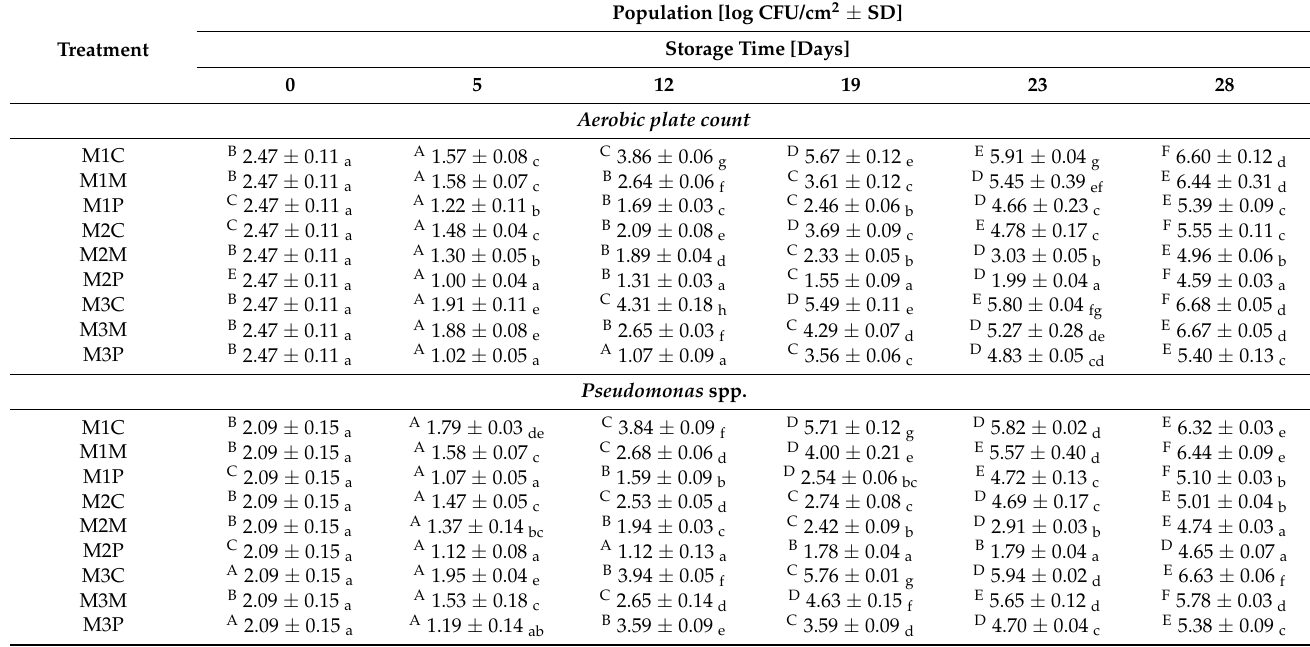
All values are mean ± SD of the replicates (8); (a–f) means with the same subscript are not different ( p > 0.05)-effect of treatments; (A–F) means with the same superscript are not different ( p > 0.05)-effect of time; (M1—65:25:10 O 2 :CO 2 :N 2 , M2—50:40:10 O 2 :CO 2 :N 2 M3—80:20 O 2 :CO 2 , C—control, M—monomer, P—modified